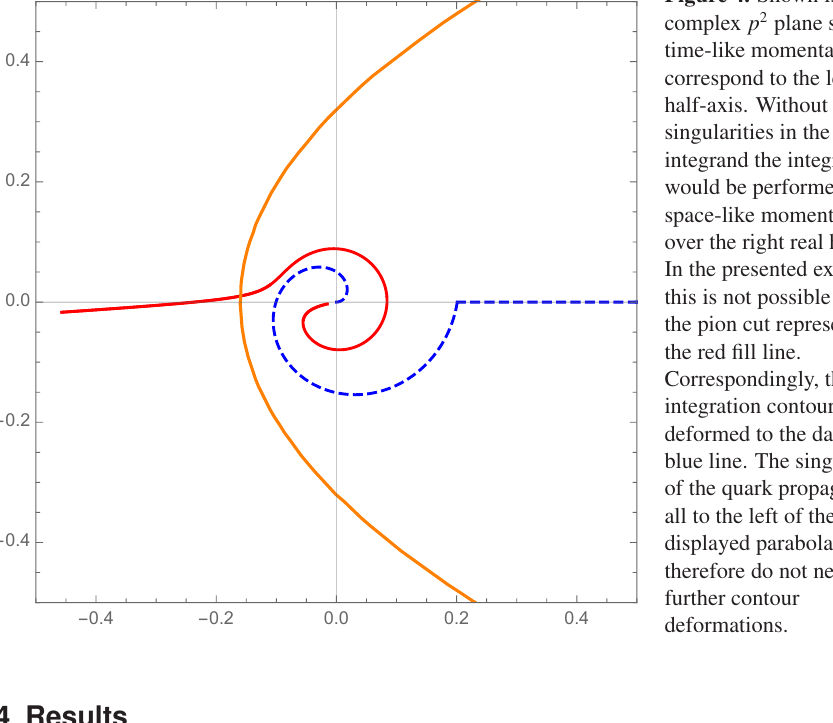
Figure 3. Truncations used herein for the Bethe-Salpeter interaction kernel K (upper diagram) and the quark Dyson-Schwinger equation (lower diagram). In the upper diagram, the terms on the right- hand side correspond to the gluon, pion exchange, and s- and u-channel pion decay contributions to the truncation, respectively. The s- and u-channel pion decay terms do not contribute to the quark Dyson-Schwinger equation.